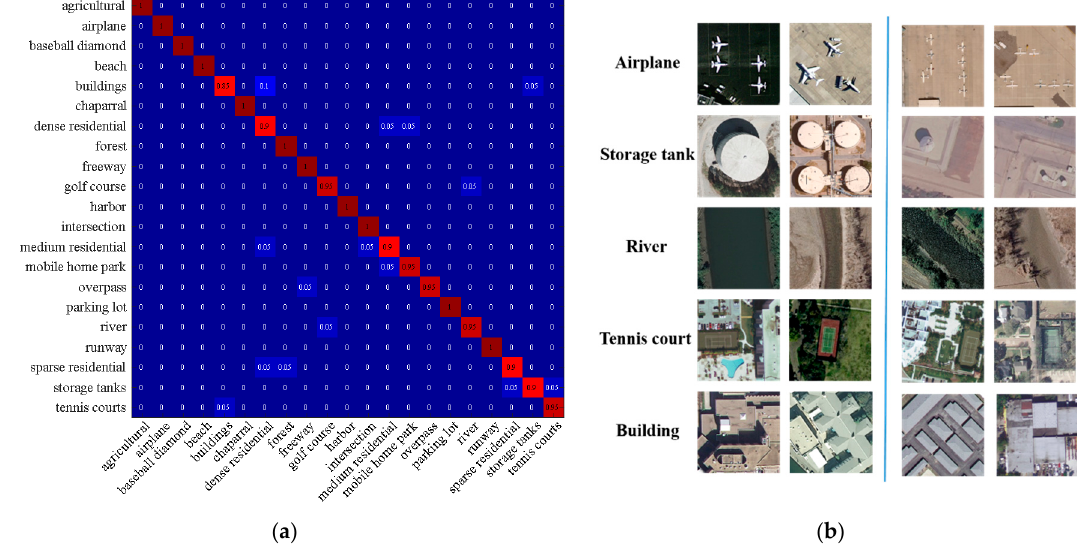
Figure 7. ( a ) The confusion matrix for the UCM dataset based on SRSCNN. ( b ) Some of the classification results of CNNV and SRSCNN with the UCM dataset. Left: correctly recognized images for both strategies. Right: images correctly recognized by SRSCNN, but incorrectly classified by CNNV.